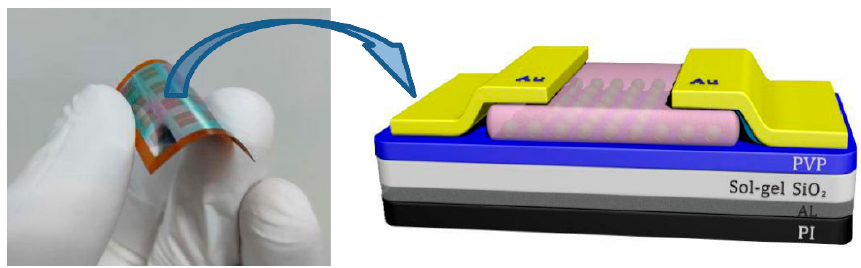
Figure 1. The schematic structures of fabricated organic thin film transistors (OTFTs) device based on polyimide (PI) substrate.